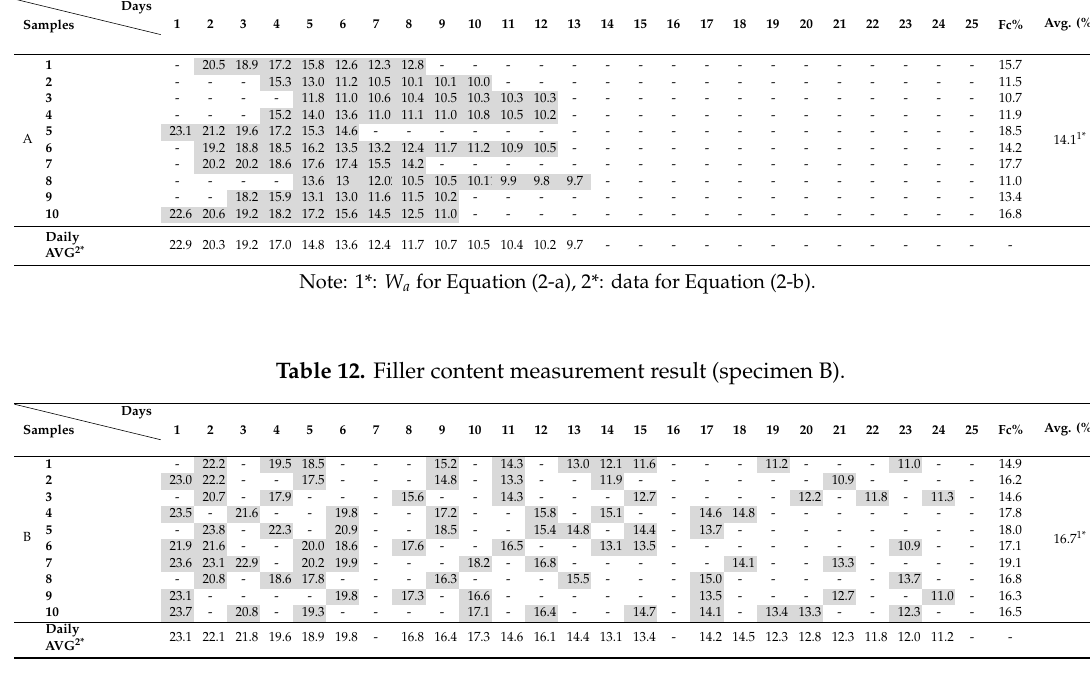
Table 11. Filler content measurement result (specimen A).